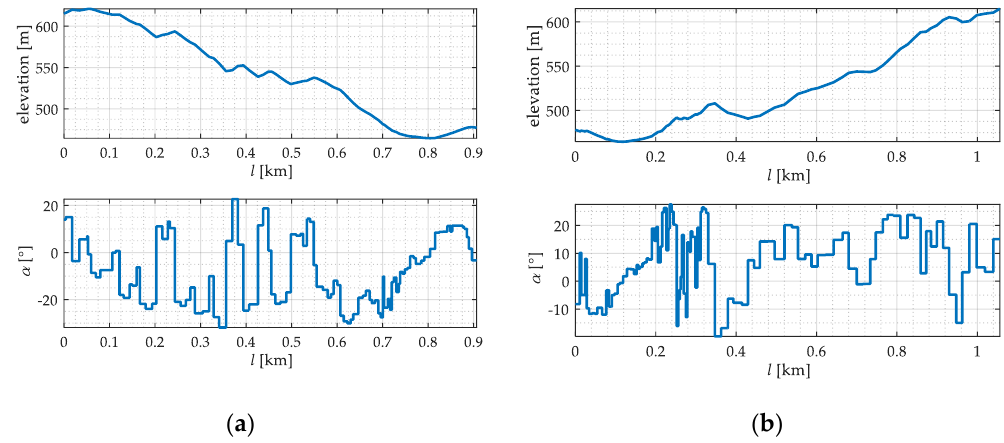
Figure 9. Elevation and terrain slope ( a ) of route 1, and ( b ) of route 2.